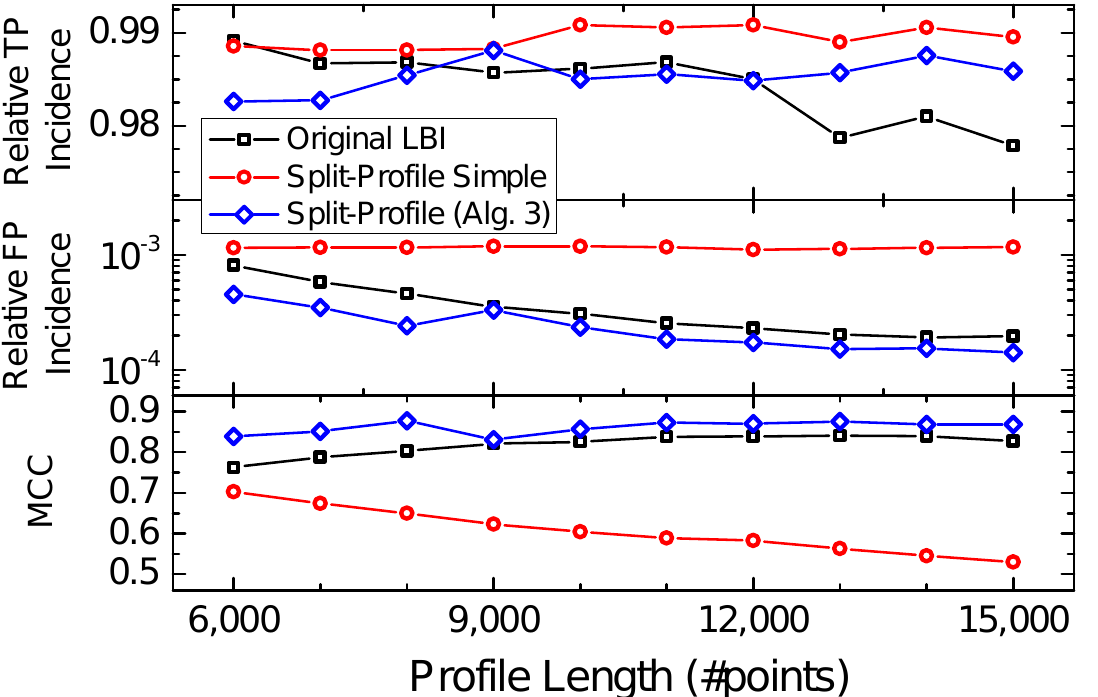
Figure 3. Performance comparison between three different versions of the analysis algorithm. Even though the differences of TPs and TFs might not seem extremely drastic for the split-profile simple, the broader characterization enabled by the MCC makes it clear that there is a deep performance drop if λ is not correctly